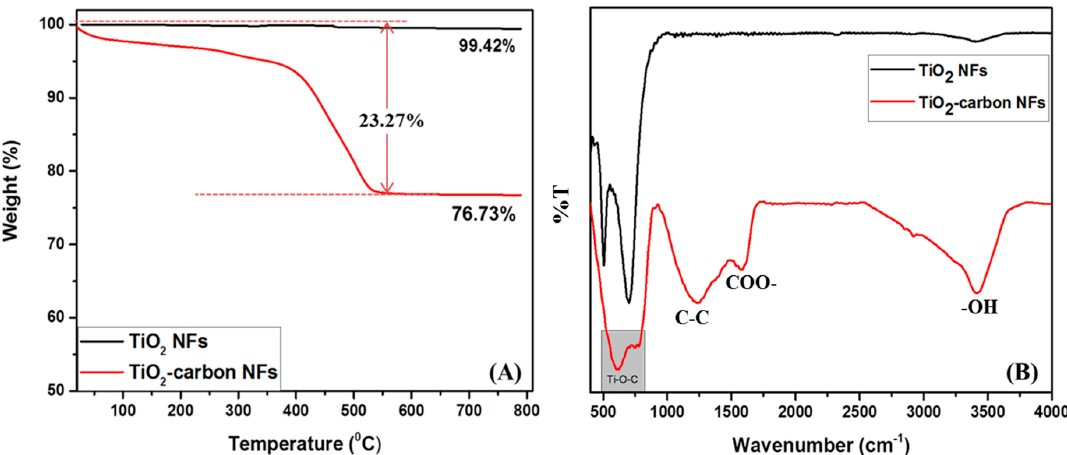
Figure 7. Thermogravimetric analysis (TGA) ( A ) and Fourier transform infrared spectroscopy (FTIR) spectra ( B ) of the TiO 2 -carbon NFs as compared to the TiO 2 NFs.